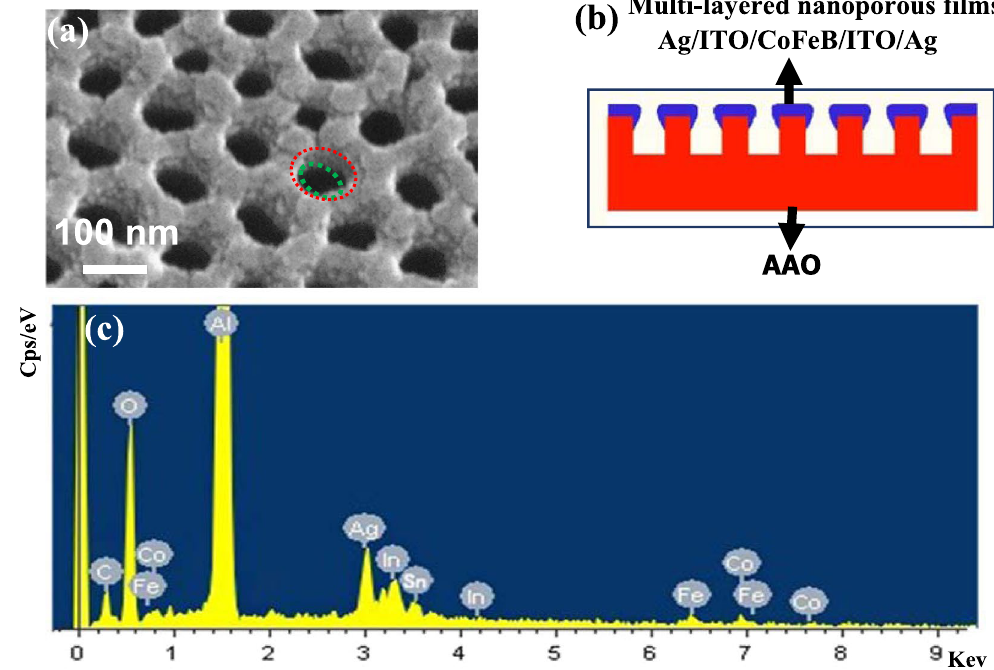
Figure 2. ( a ) Angle tilted magnified SEM images of Ag (5 nm)/ITO (10 nm)/CoFeB (10 nm)/ITO (10 nm)/ Ag (5 nm) nanoporous films on S = 110 nm, D = 60 nm AAO template, ( b ) scheme of the cross-section of nanofunnel films and ( c ) EDS of one of multi-layered nanoporous films suggesting that these films have Ag, Co, Fe, Sn, In, Al and O